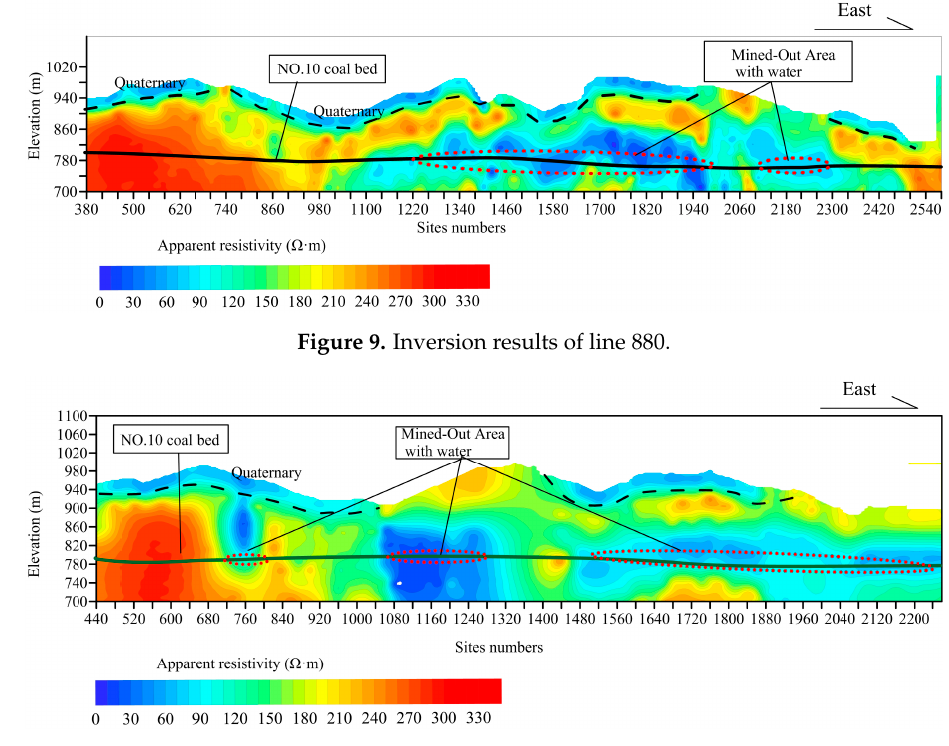
Figure 10. Inversion results of line 960.